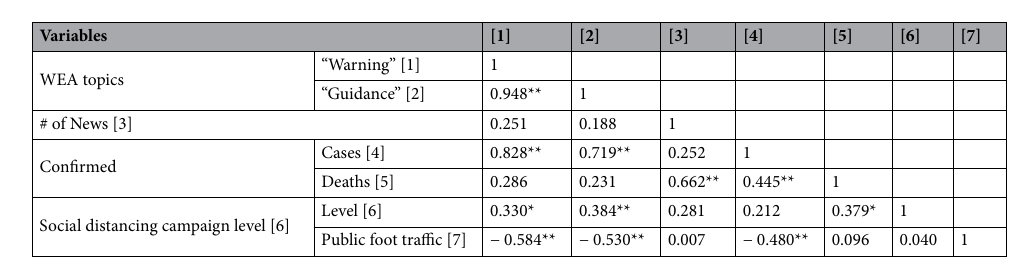
Table 1. Results of the correlation analysis using the national data set. WEA, wireless emergency alerts. *p < 0.05, **p < 0.01. Pearson Correlation Coefficient, N = 45.